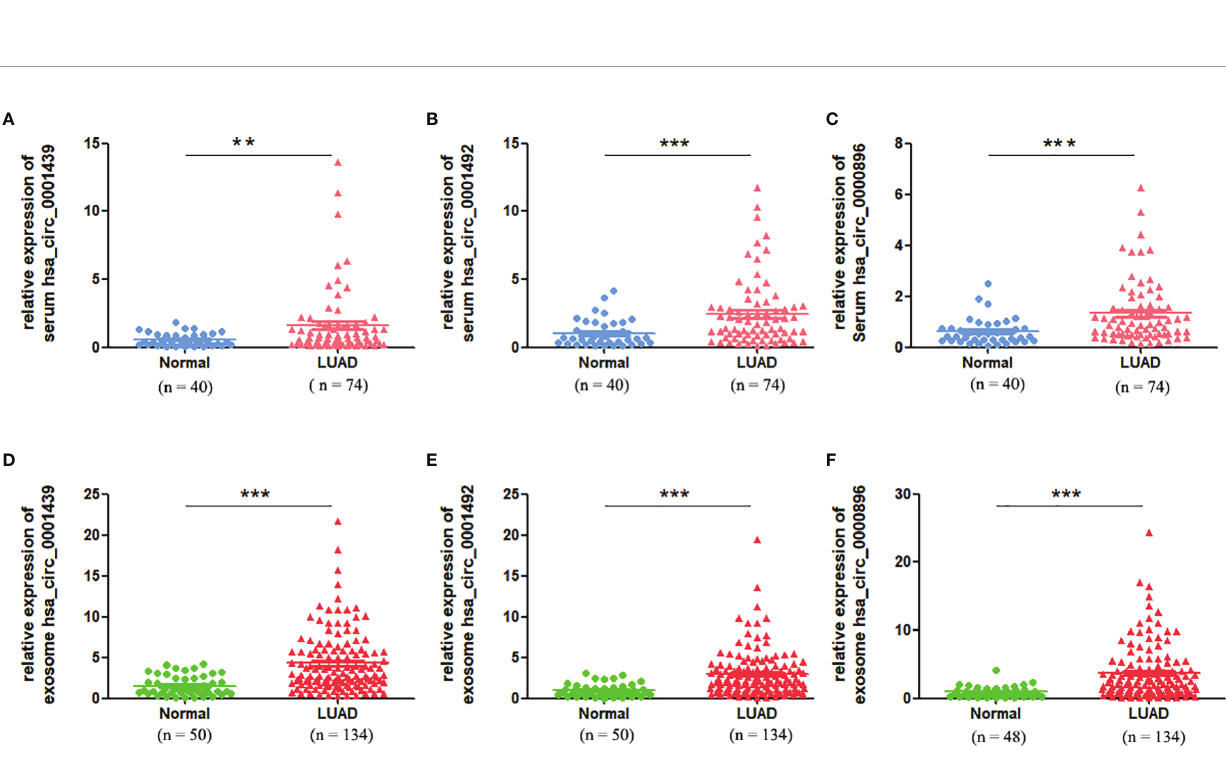
FIGURE 2 | The serum expression levels of has_circ_0001439 (A) , hsa_circ_0001492 (B) , and hsa_circ_0000896(C) in LUAD (n=74). The serum exosomal expression levels of hsa_circ_0001439 (D) , hsa_circ_0001492 (E) , and hsa_circ_0000896 (F) in LUAD (n=134). (**P < 0.01, ***P <